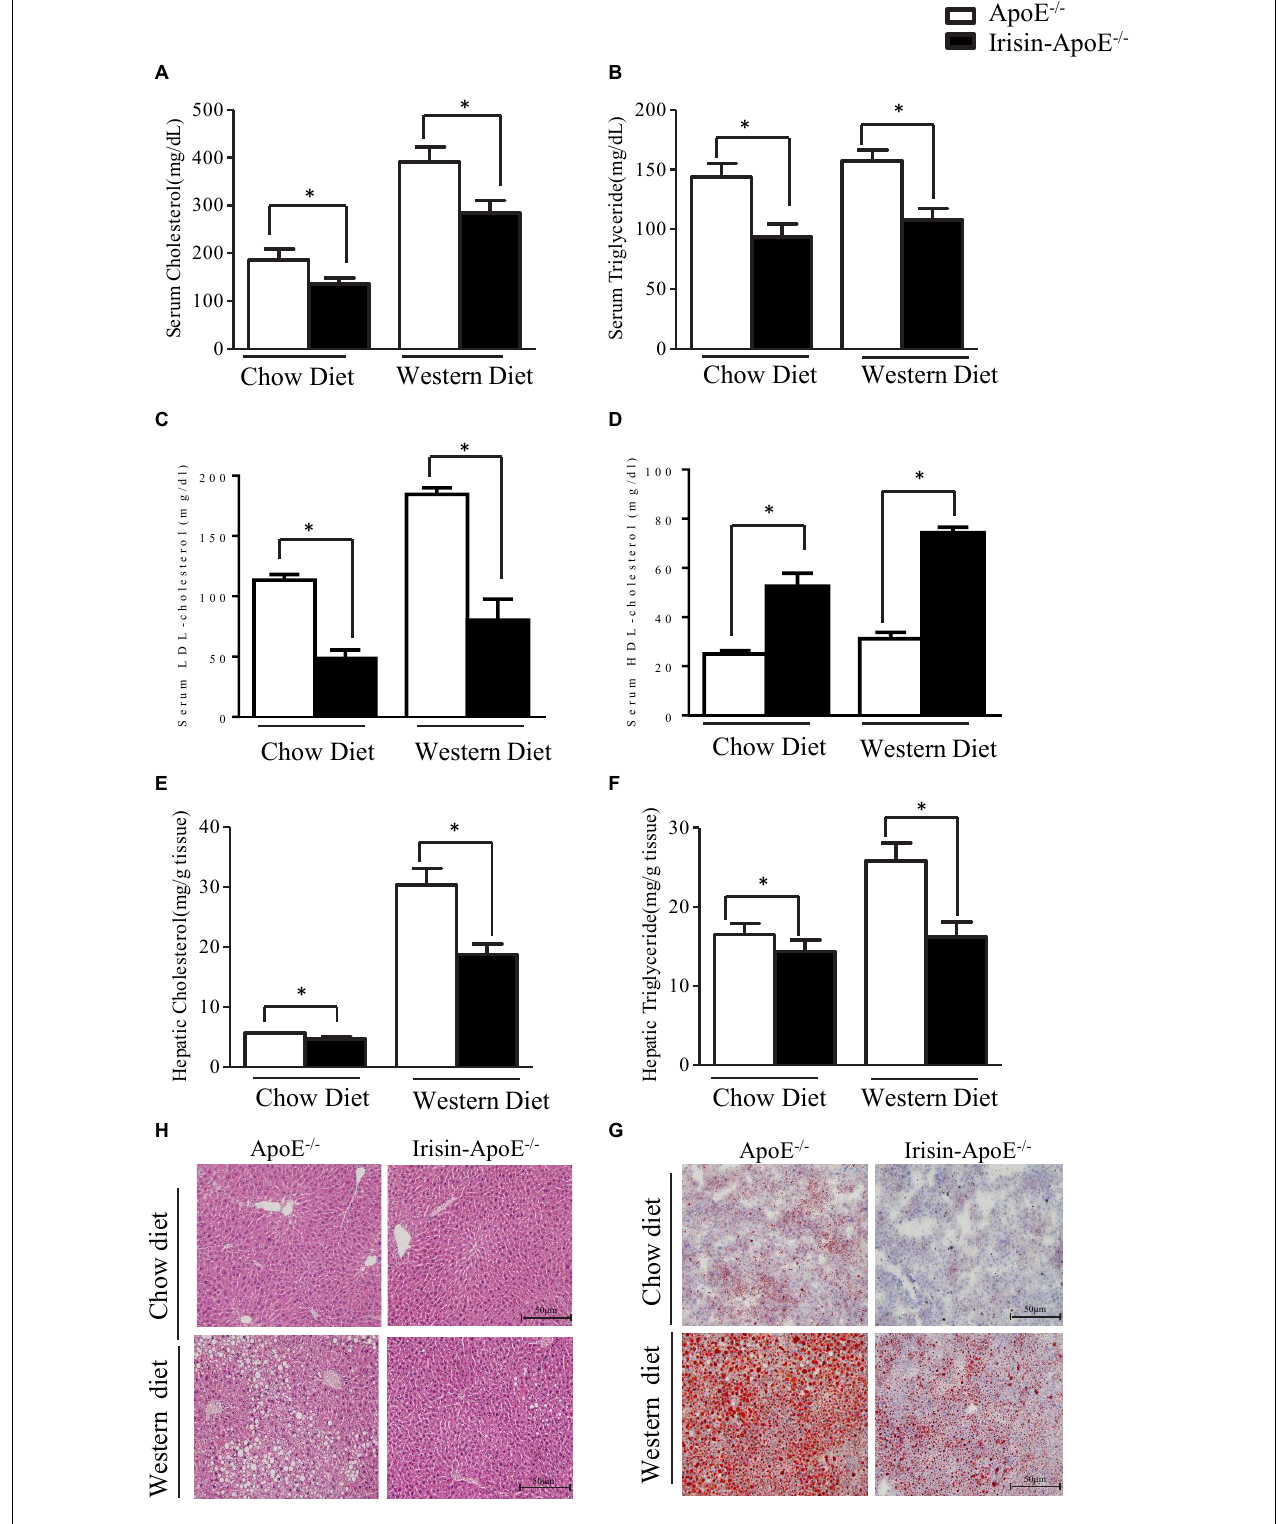
FIGURE 3 | Serum parameters and hepatic lipid in ApoE − / − and Irisin-ApoE − / − mice. ApoE − / − and Irisin-ApoE − / − mice 20 weeks old were fed a chow or Western diet for 8 weeks. (A–D) Serum levels of cholesterol ( n = 7), triglycerides ( n = 7), LDL-cholesterol, and HDL-cholesterol ( n = 4) in mice. (E,F) Hepatic cholesterol and triglycerides levels in mice ( n = 6). (G,H) Representative H&E and Oil-red O staining of liver sections. Data are mean ± SEM. ∗ P < 0.05.